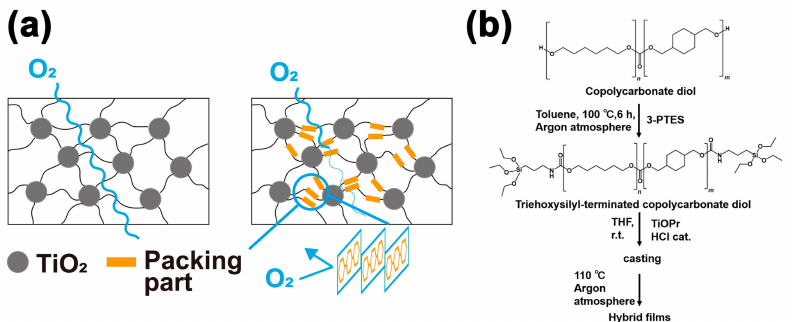
Figure 1. ( a ) Schematic diagram of the effect of the packing part constructed by the ring structure on oxygen permeability. ( b ) A modification reaction of isocyanatopropyltri- ethoxysilane (3-PTES)) of the polycarbonate diol and sol-gel reaction for preparing to titania contained polycarbonate